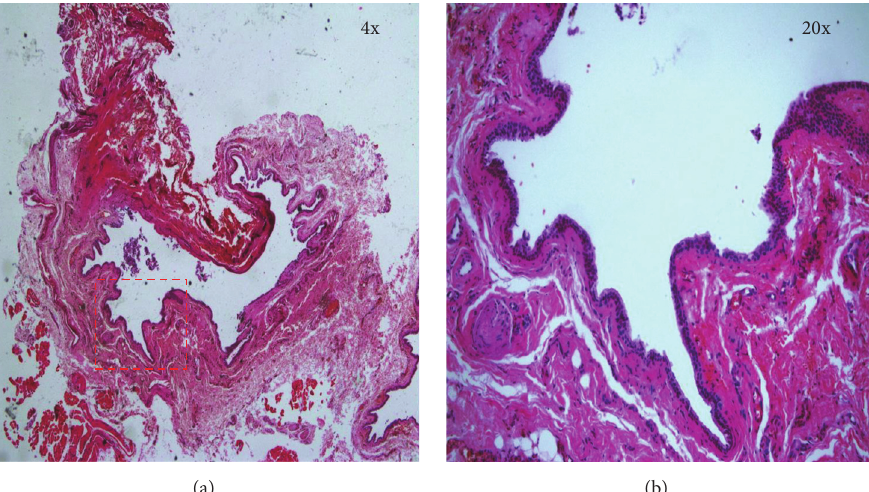
Figure 3: Light microscopy appearances of the cyst at 4x (a) and 20x (b) magnification. The cystic wall was lined with pseudostratified columnar